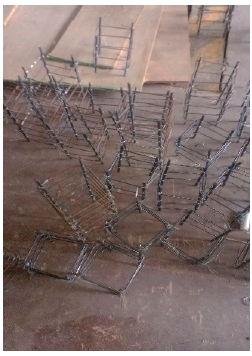
Figure 2. Assembled steel cages. Figure 3. Pullout specimens.